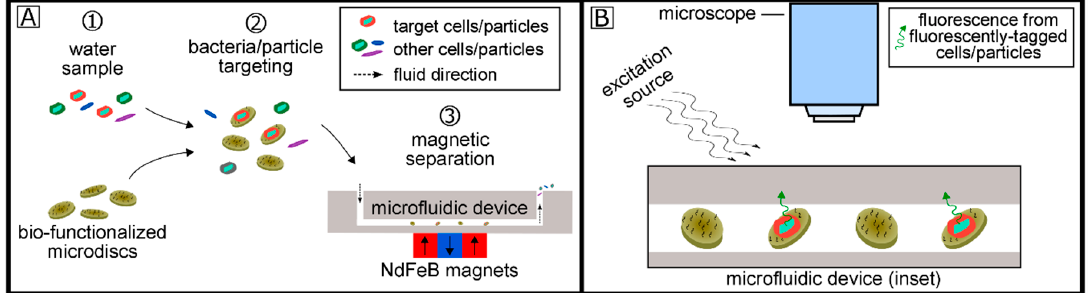
Figure 1. Overall concept on the biosensing system for bacterial target detection using bio-functionalized magnetic microdiscs and magnetic separation ( A ) and fluorescence imaging ( B ).